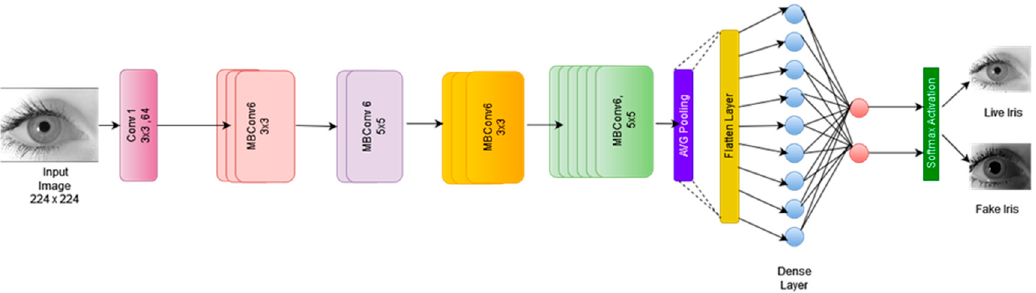
Figure 6. The EfficientNetB7 architecture, designed for iris liveness detection.